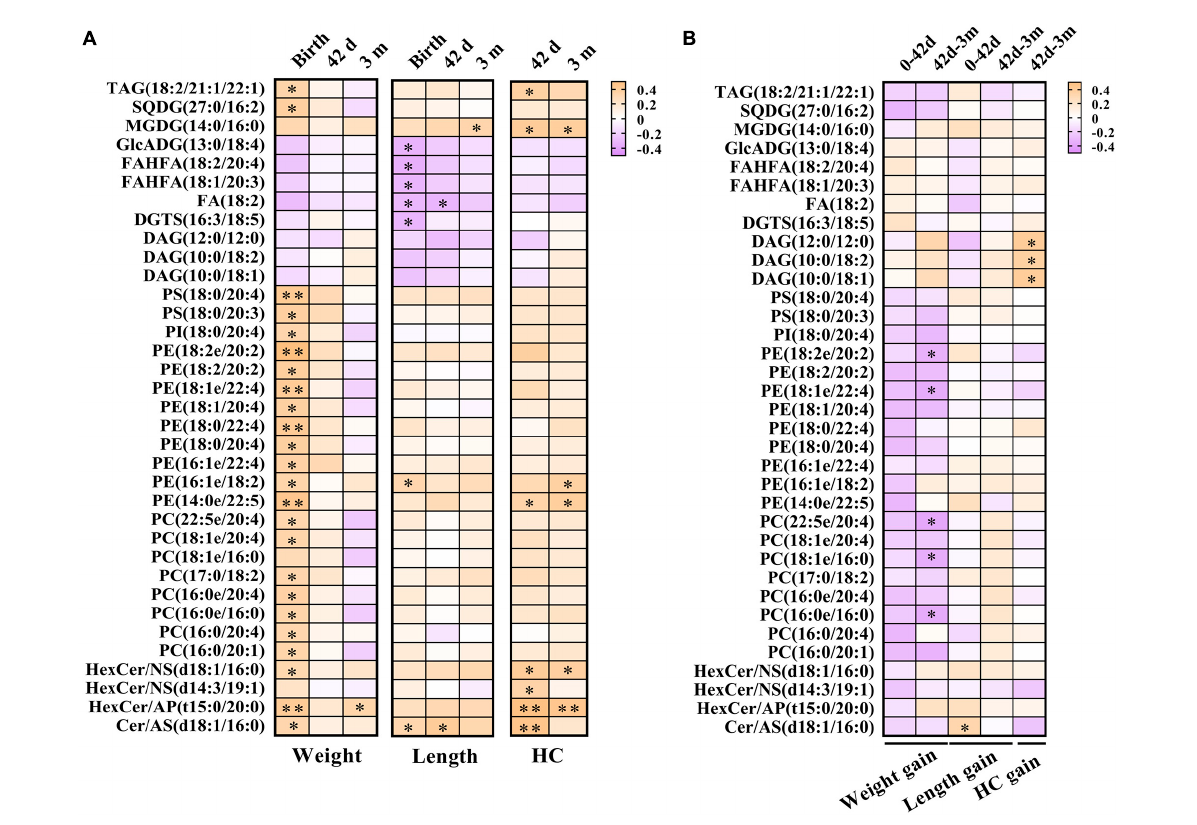
FIGURE5 Breast milk lipids in relation to infant physical development. (A) Lipid species in breast milk showed remarkable association with body weight, length, and HC. (B) Lipid species in breast milk correlated with bodyweight gain, length elevation, and HC increase. Orange color represents positive correlation and purple indicates negative correction. ∗ P < 0.05 and ∗∗ P < 0.01. HC, head circumference.